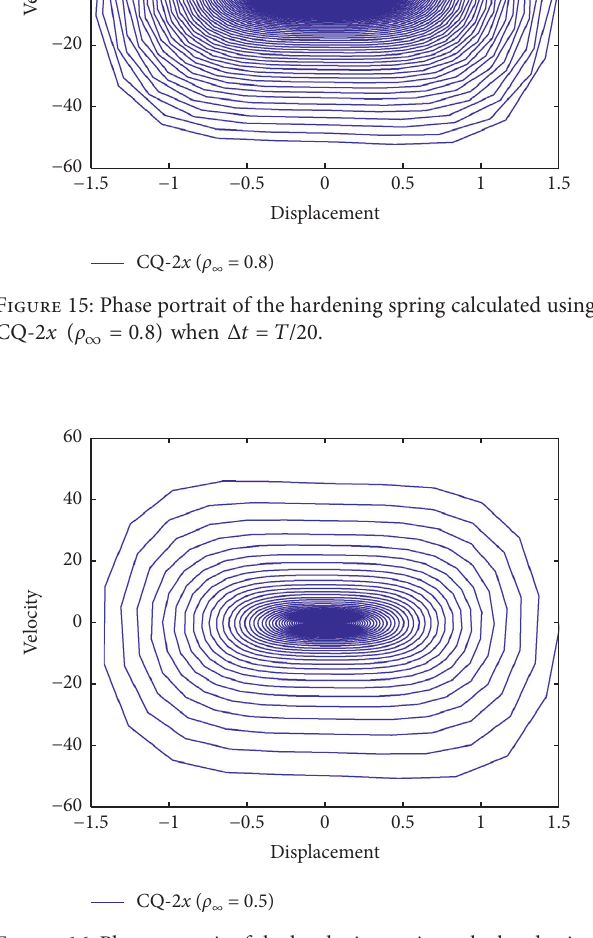
Figure 14: Phase portrait of the hardening spring calculated using � 1 ) when Δ t � T /20. CQ-2 x ( ρ ∞